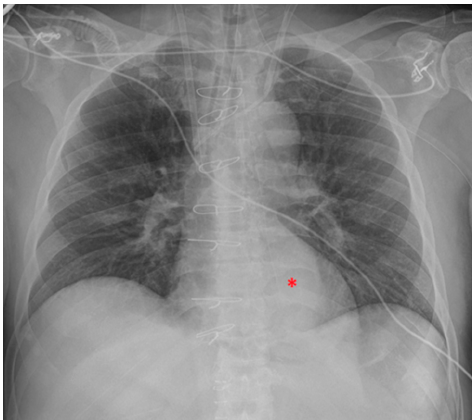
Figure 22. Image of NG tube positioned too proximally, its tip reaching the distal oesophagus and therefore projecting against the heart (red asterisk). In the same patient, the ETT has been pushed too low, with its tip proximal to the carina. The picture also shows two left jugular CVCs and a right jugular CVC.